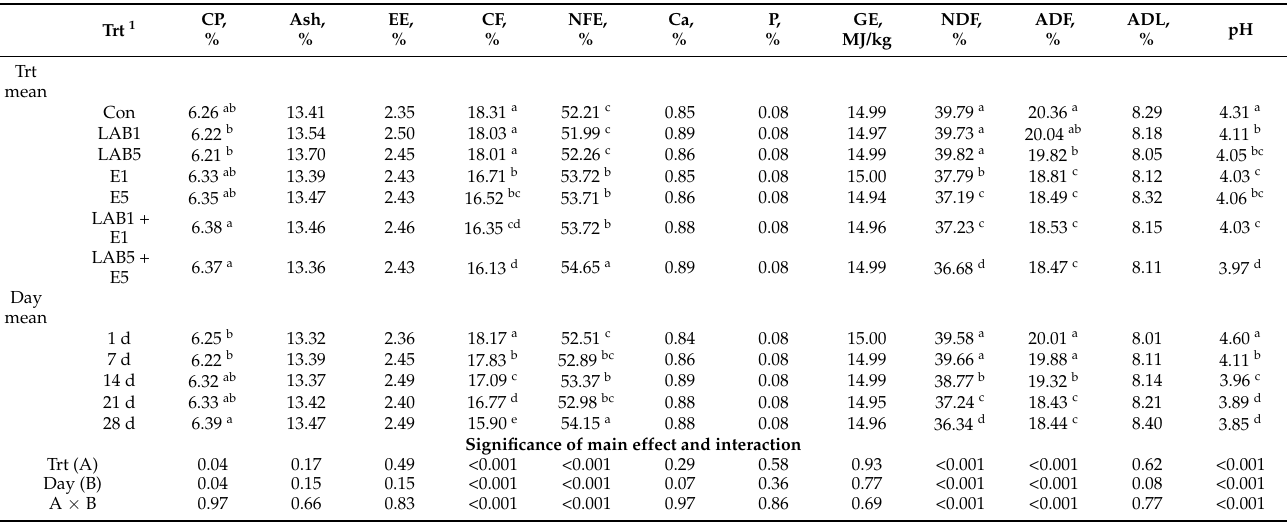
Table 5. Citric acid by-product fermented with lactic acid bacteria (LAB), enzyme, and combination of nutrient composition, gross energy (GE), and